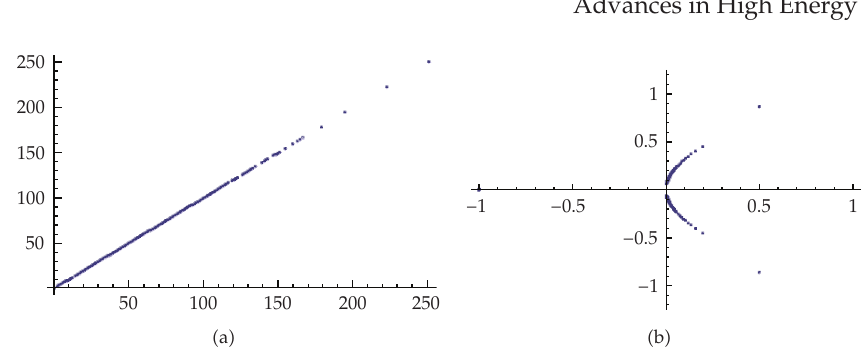
Figure 5: (cid:5) a (cid:6) The Hodge number of self-mirror Calabi-Yau threefolds; these have − 1 as a root of the Poincar´e polynomial. (cid:5) b (cid:6) All of the roots of the Poincar´e polynomial of these self-mirrors.